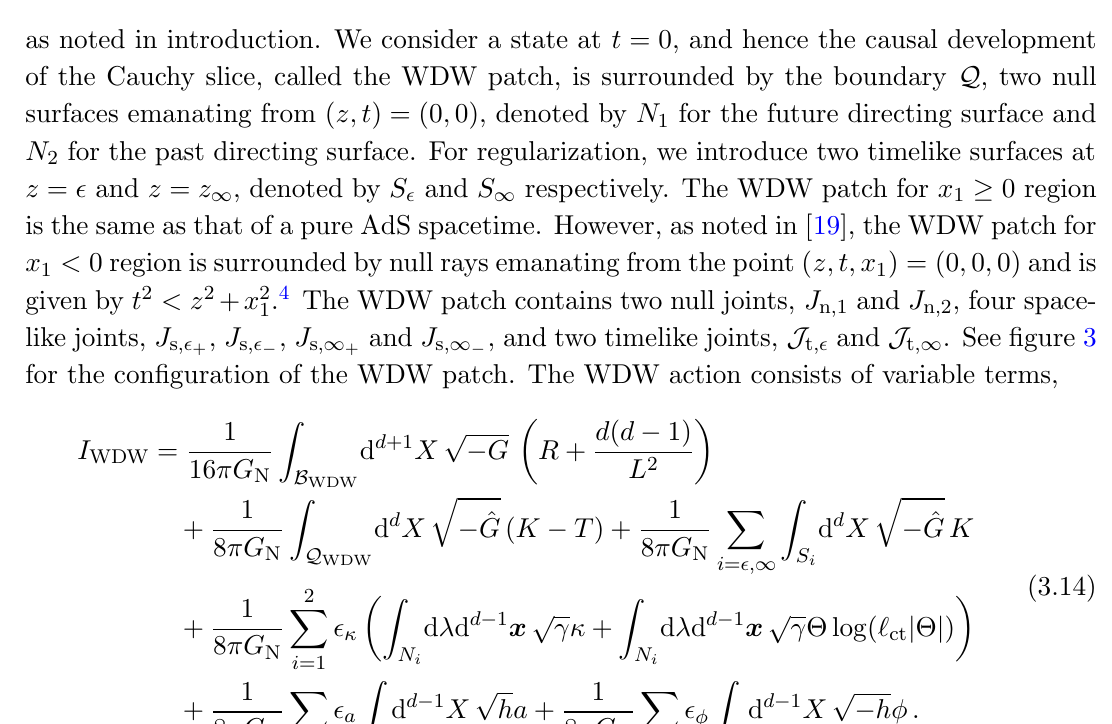
= N 1 ; 2 \ S (cid:15) and (cid:6) and (cid:6)